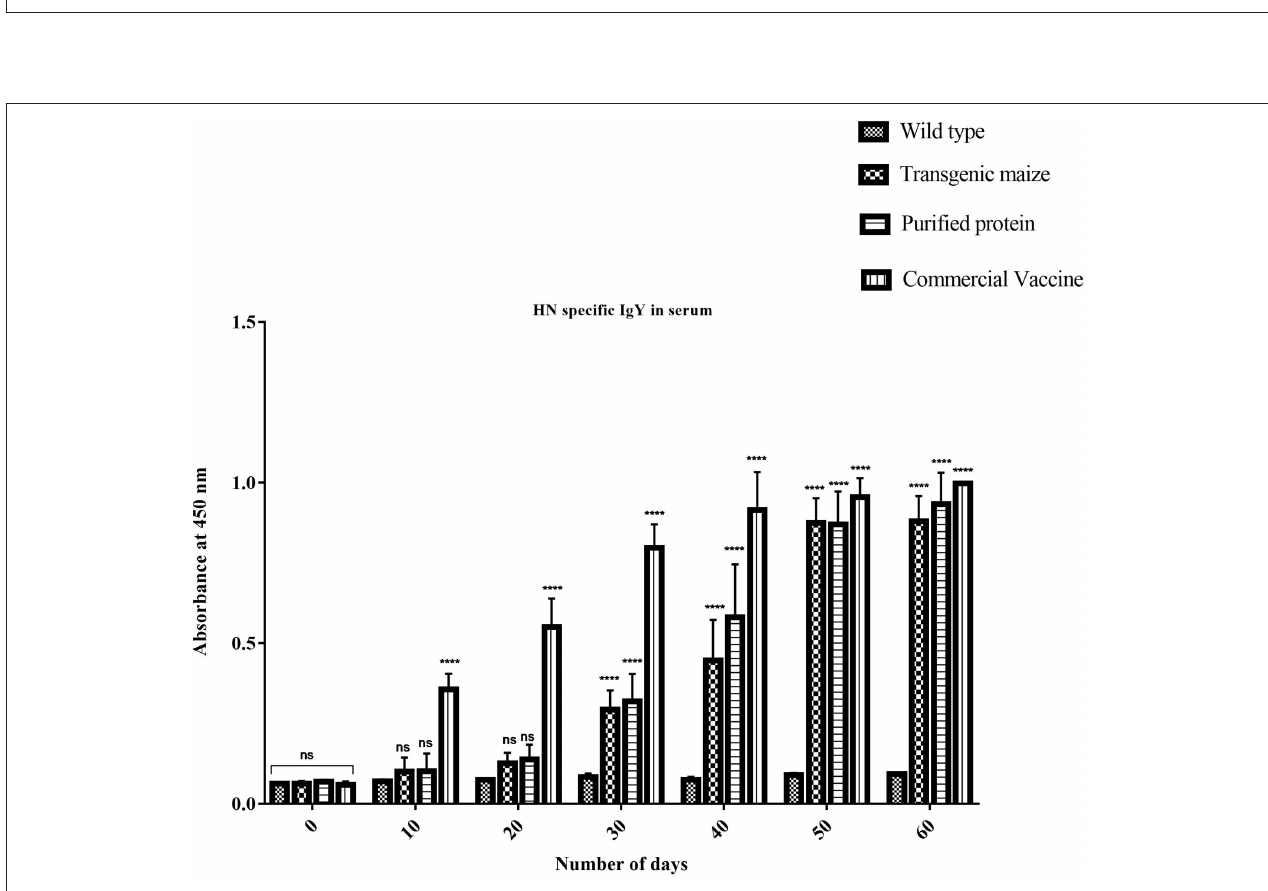
FIGURE 8 | Serum specific IgY response against HN protein. HN specific Serum IgY immune responses in Chicken immunized with transgenic maize seeds. Groups of 18 days old chicken were immunized on day 0, 10, 20, 30, 40, 50, and 60. IgY level against HN protein was almost similar at 50 and 60 days immunization to the chicken vaccinated through injection of recombinant HN protein from E. coli and commercially available vaccine against NDV. While no immunogenic response was observed in group receiving non-transgenic maize. Data shown are average ± SD ( n = 5/group). The significance of the data is determined by one-way ANOVA and p < 0.0001 is indicated by “****” above bars whereas “ns,” non-significant.